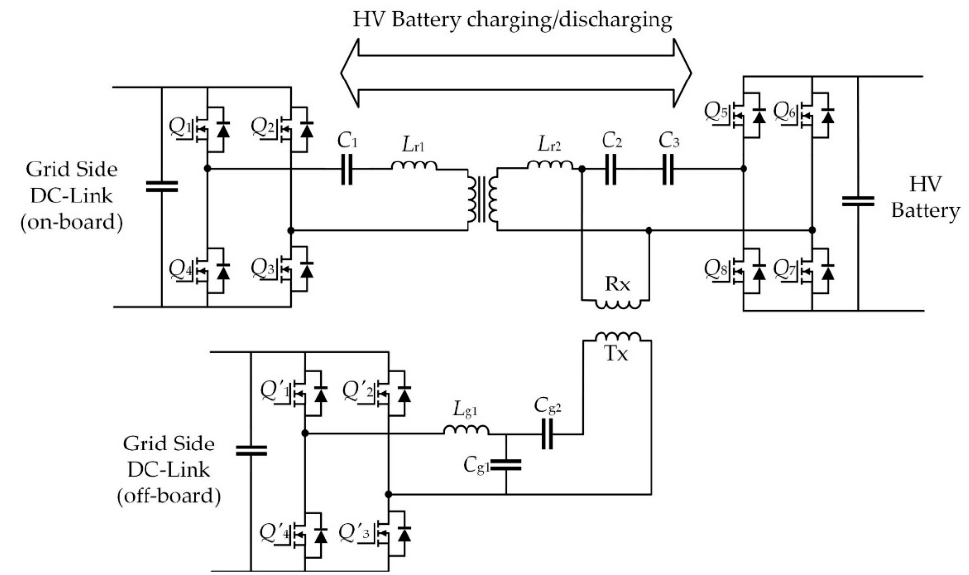
Figure 17. The integration between the conductive charger and the wireless charger.